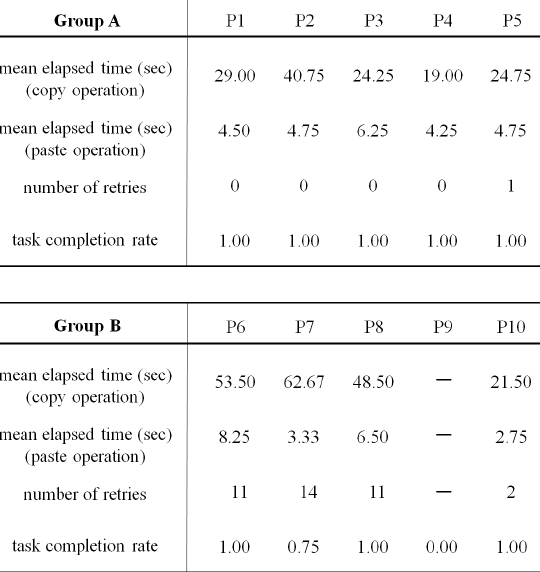
Fig. 9. Copy mode. (a) Setting the initial cursor to the start position of a text region to copy. (b) Setting the cursor to the end position of the text region